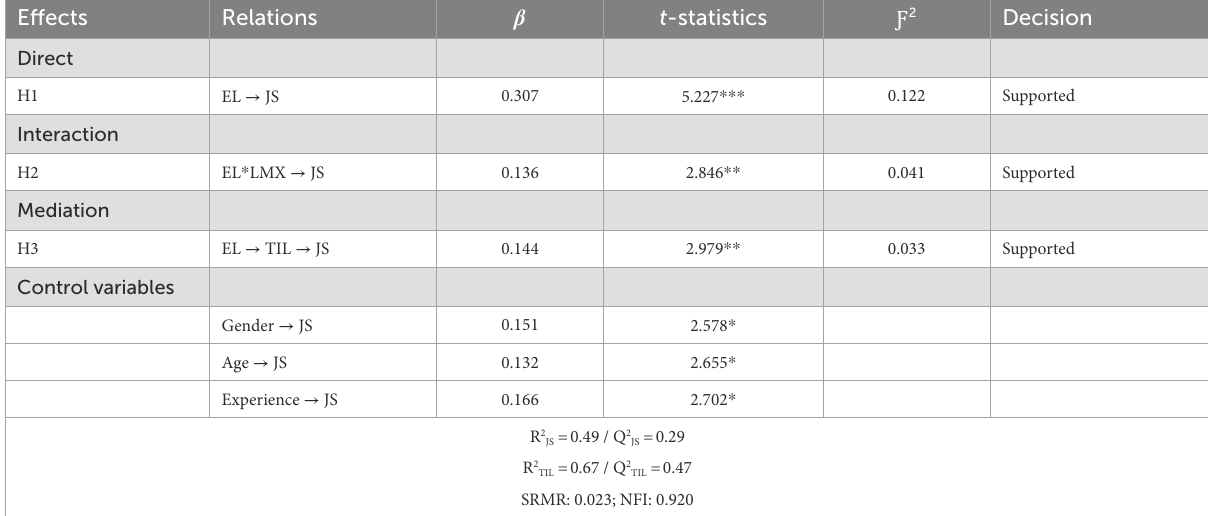
TABLE 4 Hypothesis